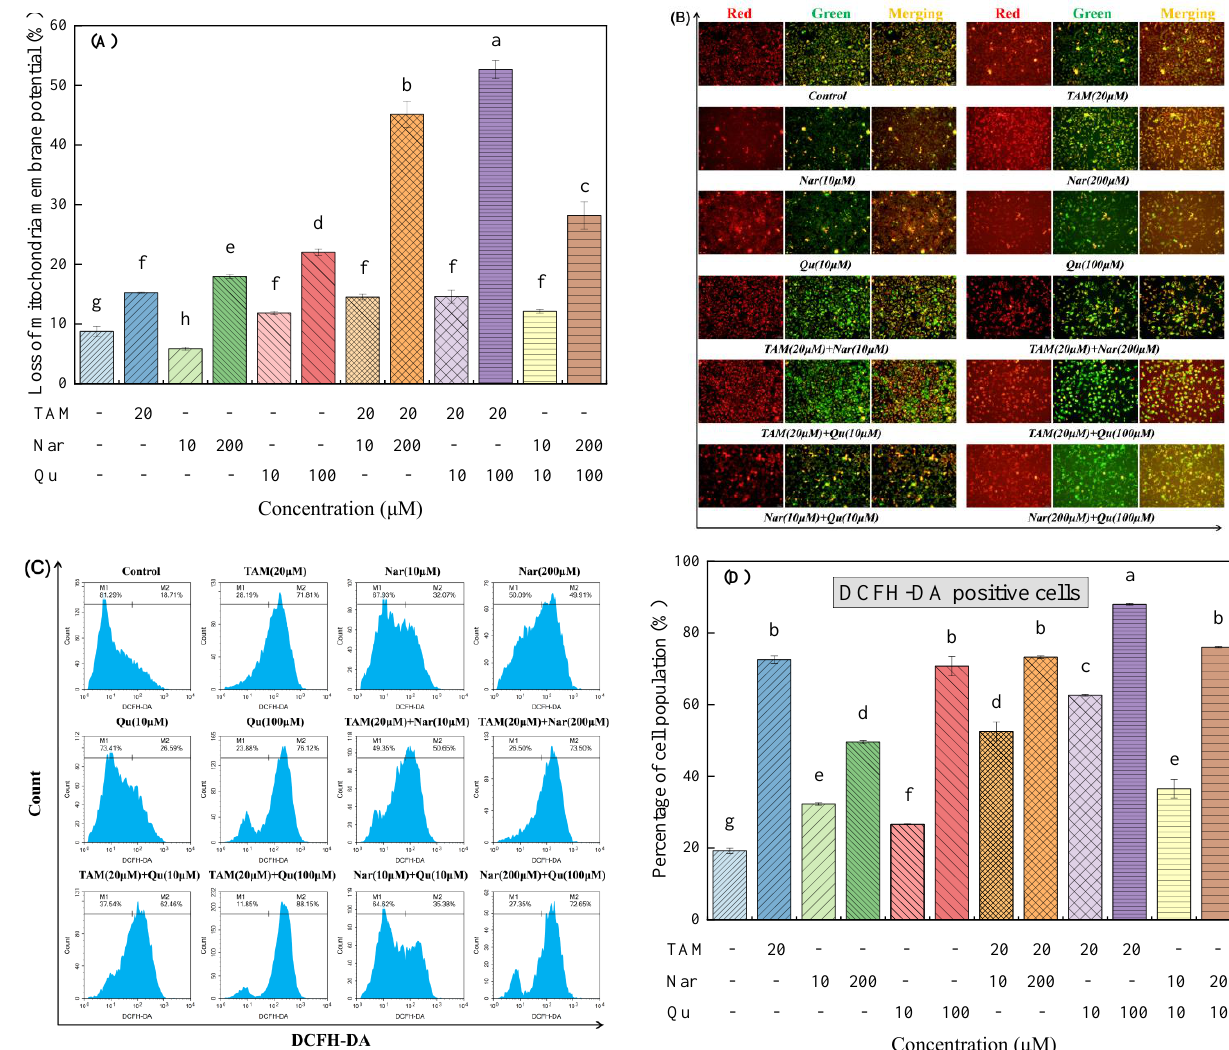
Figure 9. Tamoxifen, naringenin and quercetin regulated mitochondrial membrane potential and reactive oxygen species generation in HepG2 cells. Cells were exposed to tamoxifen (20 μM), naringenin (10 and 200 μM) and quercetin (10 and 100 μM) either alone or in combination for 24 h. ( A ) Percentage of mitochondrial membrane potential loss by JC-1 staining is represented as a bar diagram. ( B ) Loss of ∆Ψ m was monitored with JC-1 dye using fluorescence microscopy at a magnification of 200 × . ( C ) Representative flow cytometry images showed that tamoxifen, naringenin and quercetin regulated ROS generation compared with the untreated control group. ( D ) The percentage of the cell population of DFCH-DA positive is represented as a bar diagram. Results are expressed as mean ± SD of three independent experiments ( n = 3). a,b,c,d,e,f,g,h : Different letters indicate significant differences ( p < 0.05) i n the loss of ΔΨm and ROS generation .